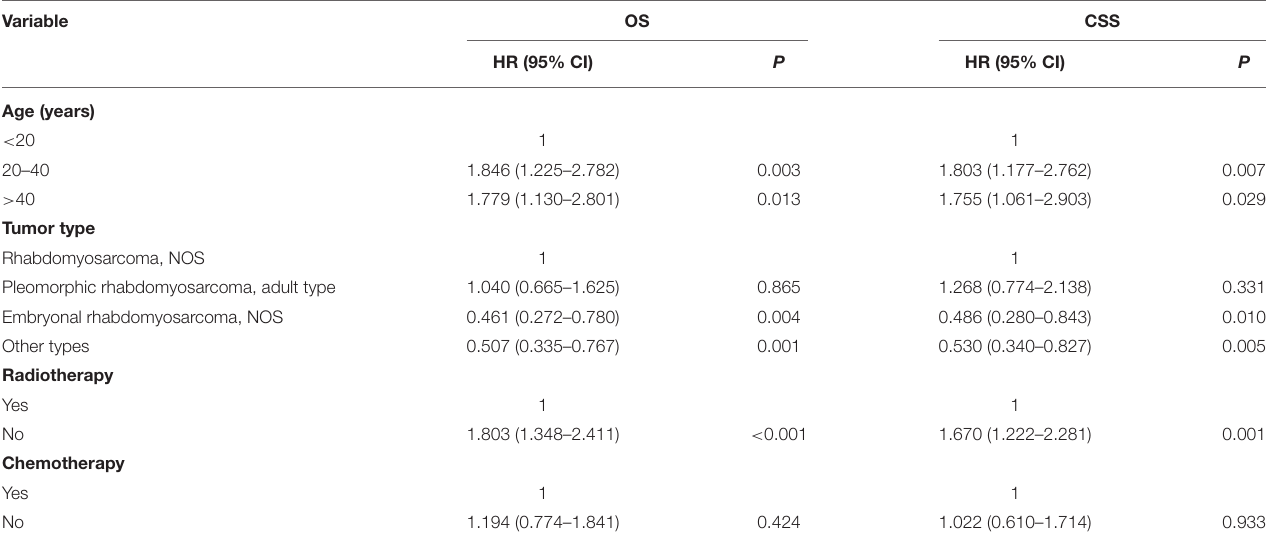
TABLE 3 | Multivariate Cox analysis for OS and CSS of patients with limb rhabdomyosarcoma and metastasis at